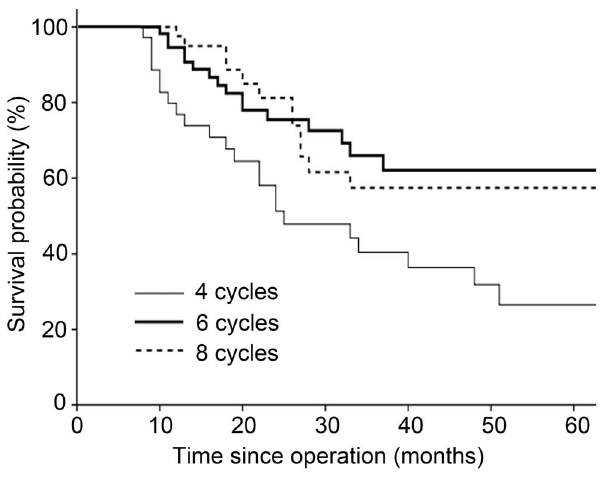
Figure 3. Kaplan-Meier survival curves by number of treatment cycles in patients with stage III cancer.